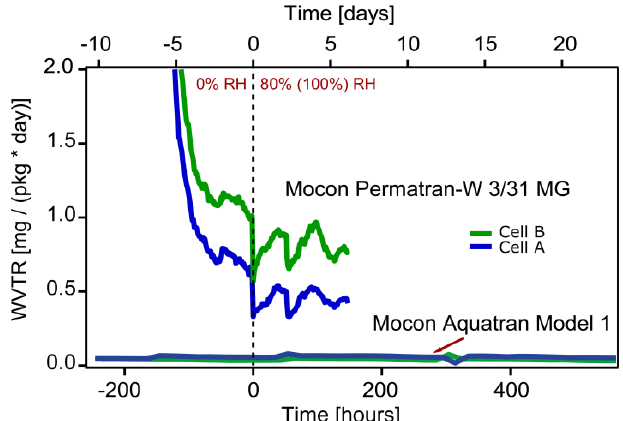
Figure 2. WVTR results from both Mocon Permatran-W 3/31 MG (100% RH) and Mocon and Aquatran Model 1 (80% RH) equipments. Cell A is the encapsulation from a fresh battery cell. Cell B is from a vibration tested